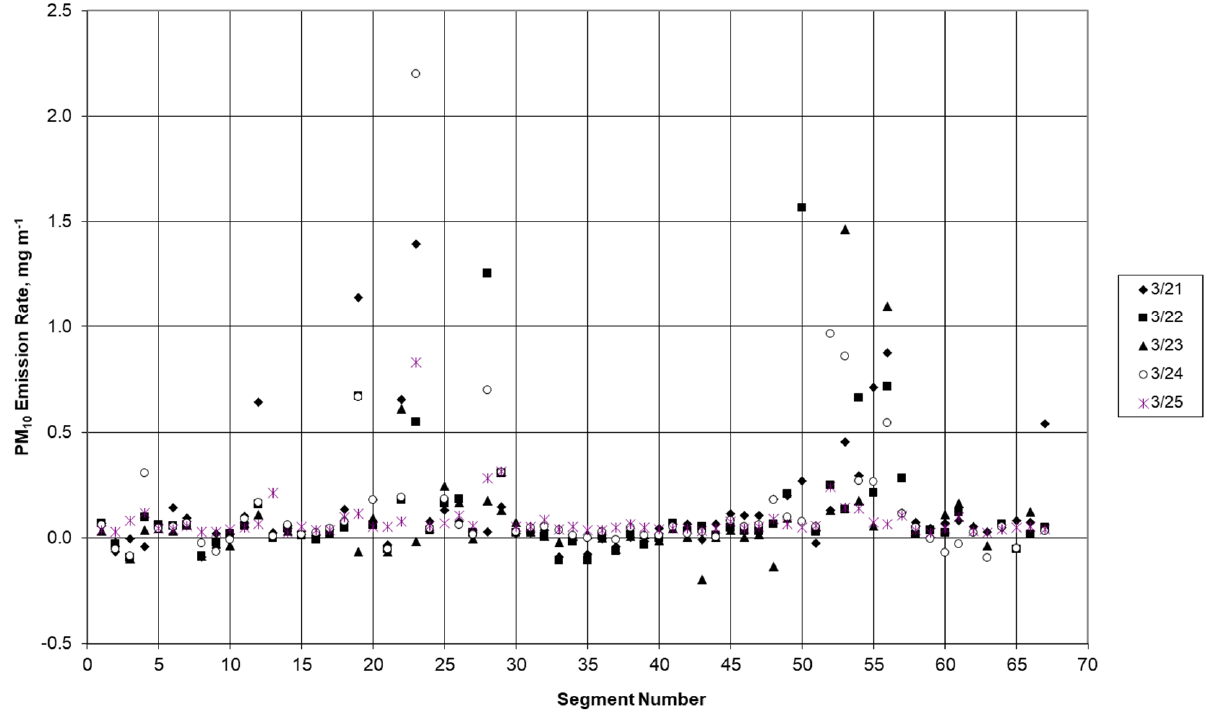
Figure 4. Plot of PM 10 emission rate by segment number starting Tuesday March 21st.